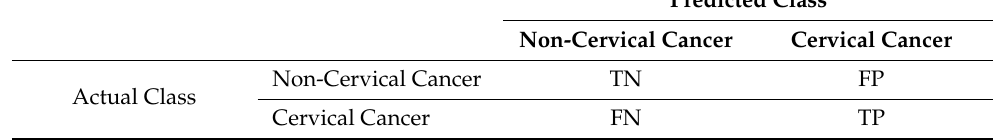
Table 4. Confusion